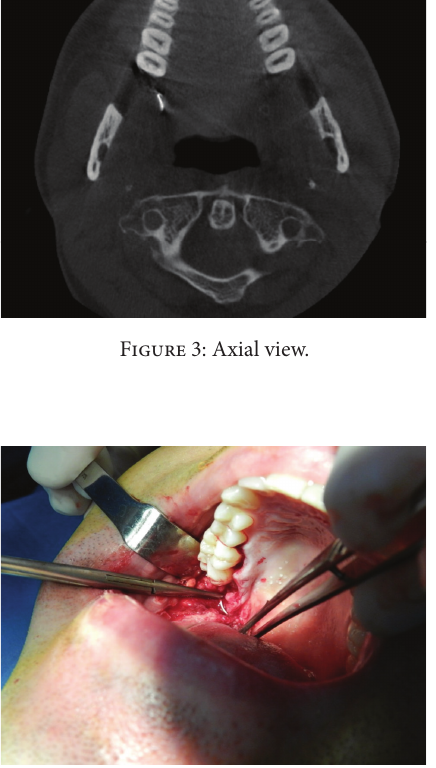
Figure 2: Sagittal view.